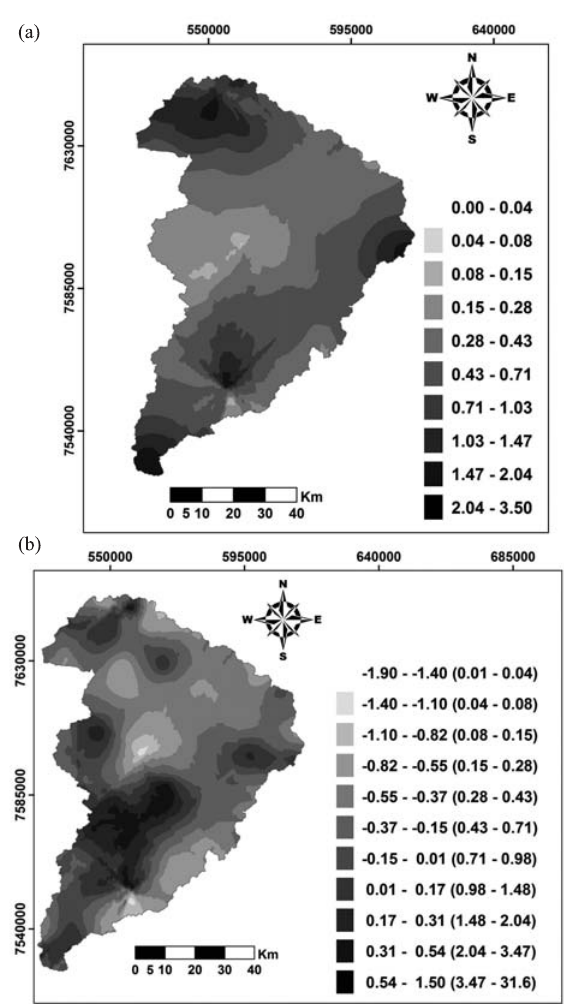
Figura 9. Distribuição espacial da condutividade hidráulica saturada com dados sem (a) e com transformação logarítmica